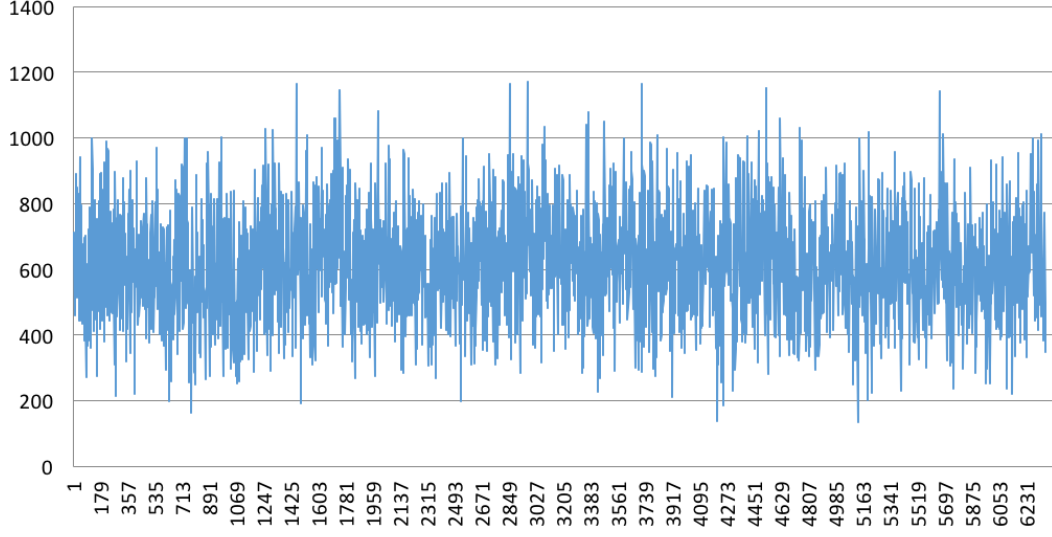
Figure 30. Latency when using an unstable